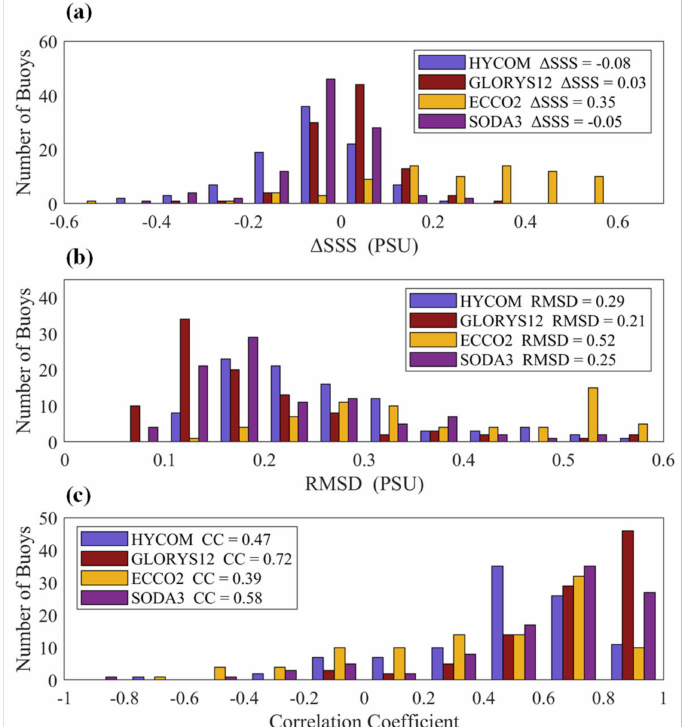
Figure 12. Histogram of ∆ SSS, RMSD and CC values between HYCOM (purple), GLORYS12 (dark red), ECCO2 (yellow), SODA3 (magenta) and GTMBA buoy salinity at 1 m. ( a ) weekly ∆ SSS, ( b ) weekly RMSD, ( c ) weekly CC values. The numbers in the top right legend are the corresponding average ∆ SSS ( a ), RMSD ( b ) and CC ( c )